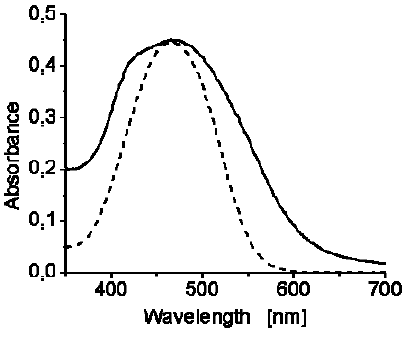
--- dissolution and LB films 24